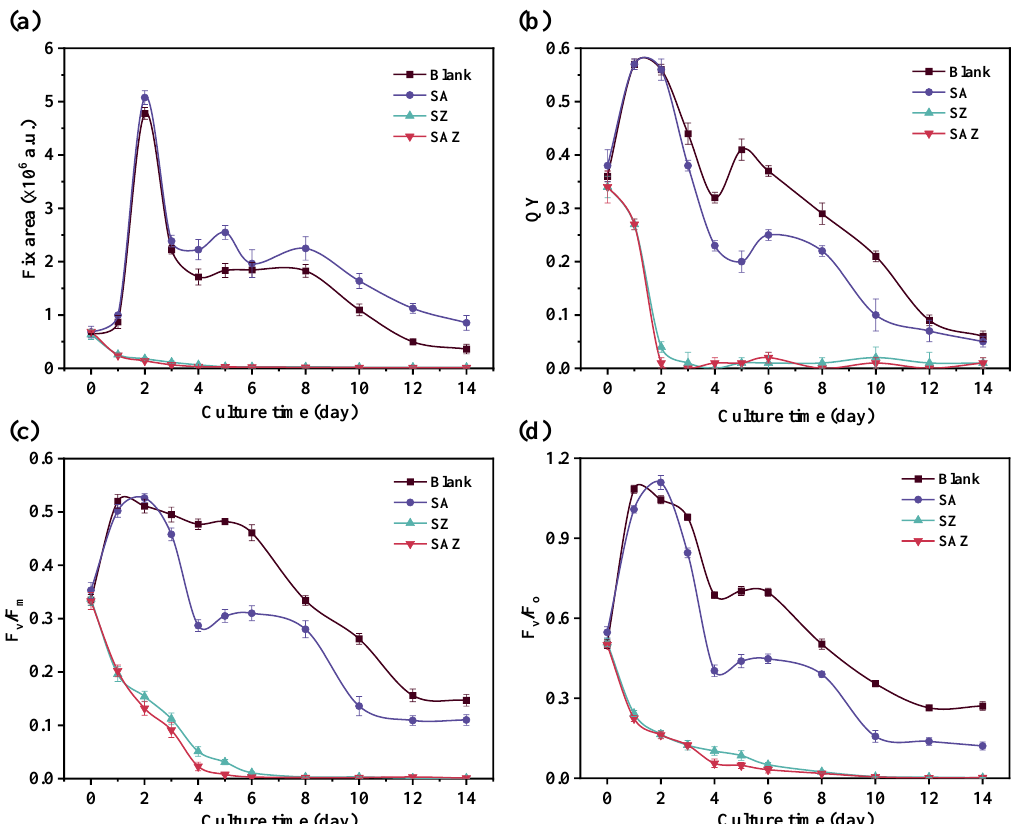
Figure 2. Chlorophyll fluorescence characteristics of S. dohrnii with different treatment in artificial seawater. Blank, S. dohrnii only; SA, with penicillin for S. dohrnii ; SZ, with Zn 2+ for S. dohrnii ; SAZ, with penicillin and Zn 2+ for S. dohrnii . Each value represents mean ± SD ( n = 3). Note error bars are smaller than the symbol sizes in some cases.